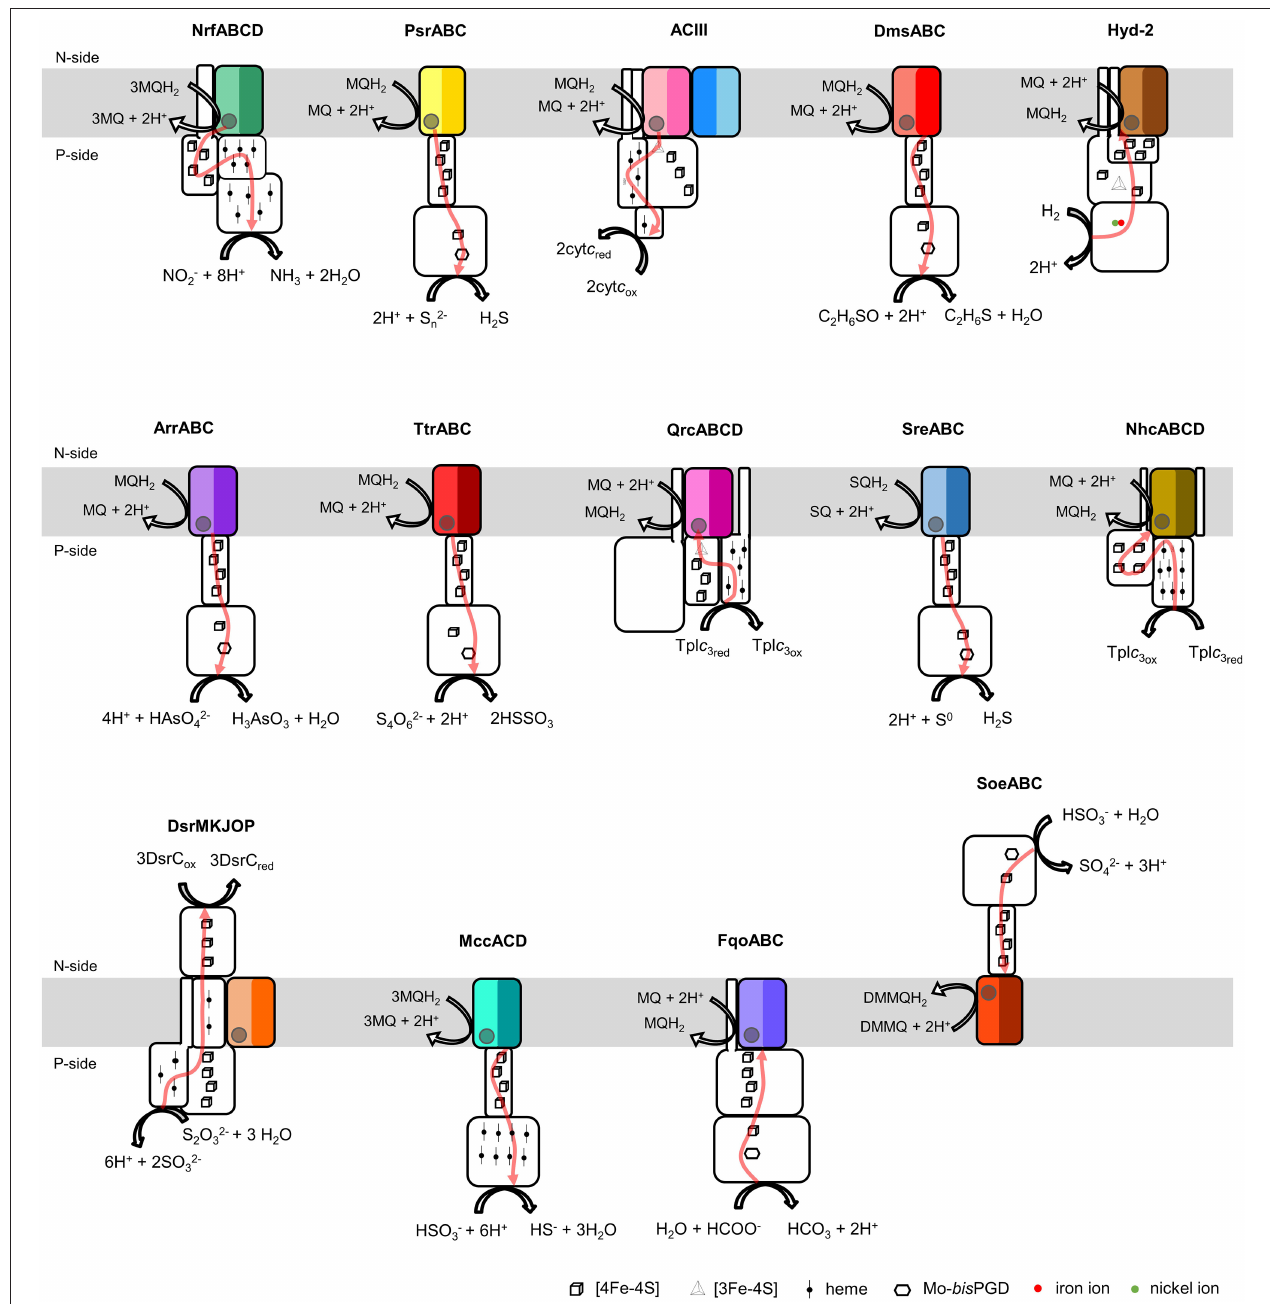
FIGURE 1 | Composition and diversity of NrfD-like subunit-containing complexes. Schematic representation of periplasmic nitrite reductase (NrfABCD), polysulfide reductase (PsrABC), respiratory alternative complex III (ACIII), DMSO reductase (DmsABC), group-2 [Ni-Fe] hydrogenase (Hyd-2), arsenate reductase (ArrABC), tetrathionate reductase (TtrABC), quinone reductase complex (QrcABCD), sulfur reductase complex (SreABC), nine-heme cytochrome complex (NhcABCD), dissimilatory sulfite-reductase complex (DsrMKJOP), multiheme cytochrome c sulfite reductase (MccACD), formate:quinone oxidoreductase (FqoABC), sulfite dehydrogenase (SoeABC). P-side, positive-side of the membrane; N-side, negative-side of the membrane. The NrfD-like subunits (NrfD, PsrC, ActC, ActF, DmsC, HybB, ArrC, ttrC, QrcD, SreC, NhcC, DsrP, MccD, fqoC, and SoeC) are colored, the two-color tones indicate the two structural repeats, each composed of a four-helix bundle (TMHs 1–4 and TMHs 5–8) and related by a 180 ◦ rotation around an axis perpendicular to the membrane. The circle, inside the colored subunits, indicates the presence of a quinone/quinol-binding site. The red arrows represent the pathway for electron transfer. The color code is used in all the following figures and in Tables 1 , 2